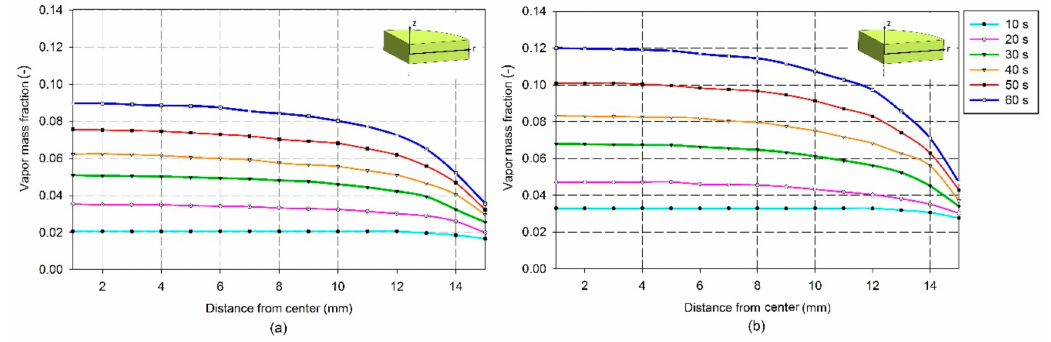
Figure 13. The vapor mass fractions profiles of ( a ) unripe bananas, and ( b ) ripe